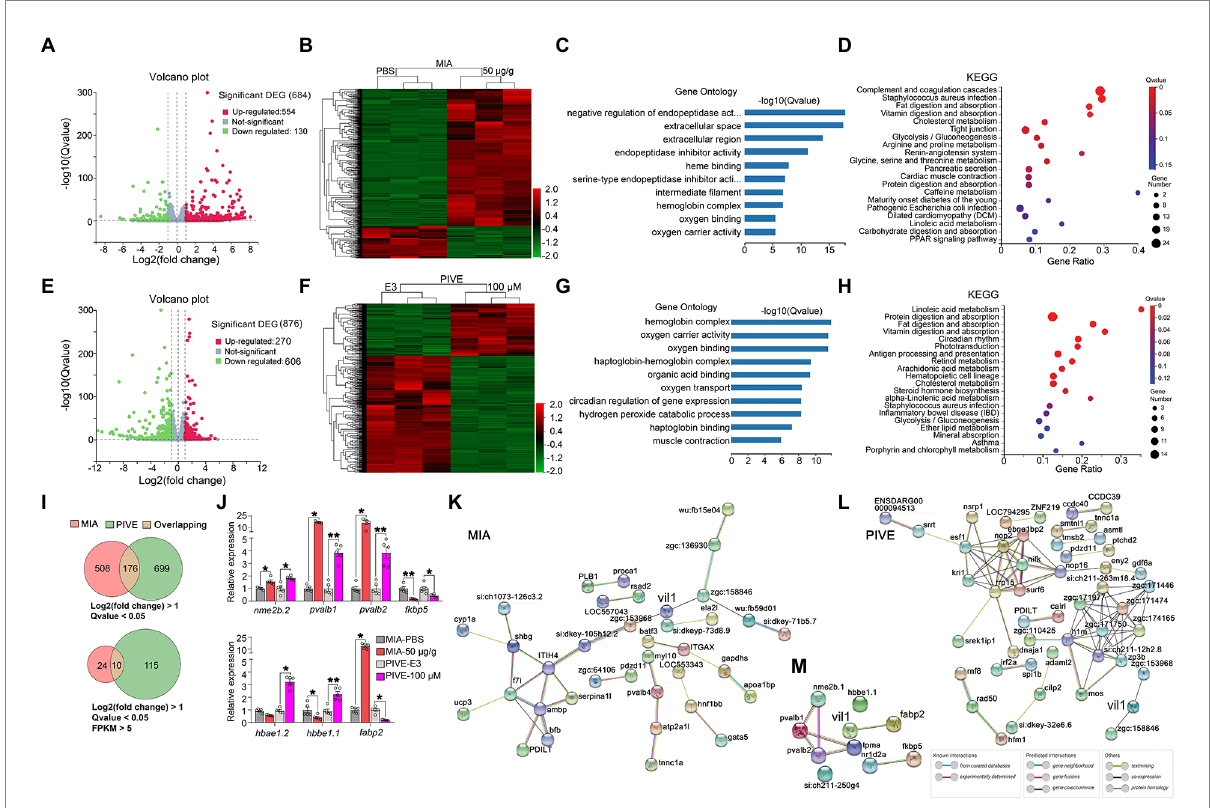
FIGURE 6 Clustering, GO enrichment and KEGG signaling pathway analysis of DEGs. (A) A volcano graph shows DEGs in MIA-50 μ g/g zebrafish brain. The red dots indicate up-regulated genes and the green dots indicate down-regulated genes. (B) The overall distribution of DEGs between the MIA- 50 μ g/g group and MIA-PBS group at 1 mpf. Red and green represent up-regulated and down-regulated changes, respectively, in the clustering analysis. The color intensity is directly proportional to the levels of changes. (C) GO analysis of MIA-induced DEGs; bar plot shows the top 10 enrichment score [ − log10 ( Q -value)] of DEGs involving biological process, cellular component, and molecular function. (D) Significant changes in the KEGG pathway of MIA-induced DEGs. The bubble graph shows enrichment score [ − log10 ( Q -value)] of the significant pathway. The size of the circle represents the number of enriched DEGs. Q -value is represented by a color scale, and the statistical significance increases from blue (relatively lower significance) to red (relatively higher significance). (E) A volcano graph shows DEGs in PIVE-100 μ M zebrafish brain. (F) The overall distribution of DEGs in the PIVE-100 μ M group and PIVE-E3 group at 1 mpf. (G) A GO analysis of PIVE-induced DEGs. (H) Significant changes in the KEGG pathway of MIA-induced DEGs. (I) Venn diagram denoting the number of all DEGs by two thresholds that are affected in MIA or PIVE offspring. (J) Quantitative RT-PCR validation of top 7 co-expressed differential gens in brain of MIA-50 μ g/g and PIVE-100 μ M group at 1 mpf [MIA- 50 μ g/g: t = 4.33, 25.00(U), 25.00(U), 1.78, 2.50 and 25.00(U), p < 0.05, 0.05, 0.05, 0.01, 0.05, and 0.05 for nme2b.2 , pvalb1 , pvalb2 , fkbp5 , hbbe1.1 , and fabp2 , respectively, vs. MIA-PBS. PIVE-100 μ M: t = 4.18, 7.63, 5.62, 3.04, 25.00(U), 5.13 and 25.00(U), p < 0.05, 0.01, 0.01, 0.05, 0.05, 0.01, and 0.05